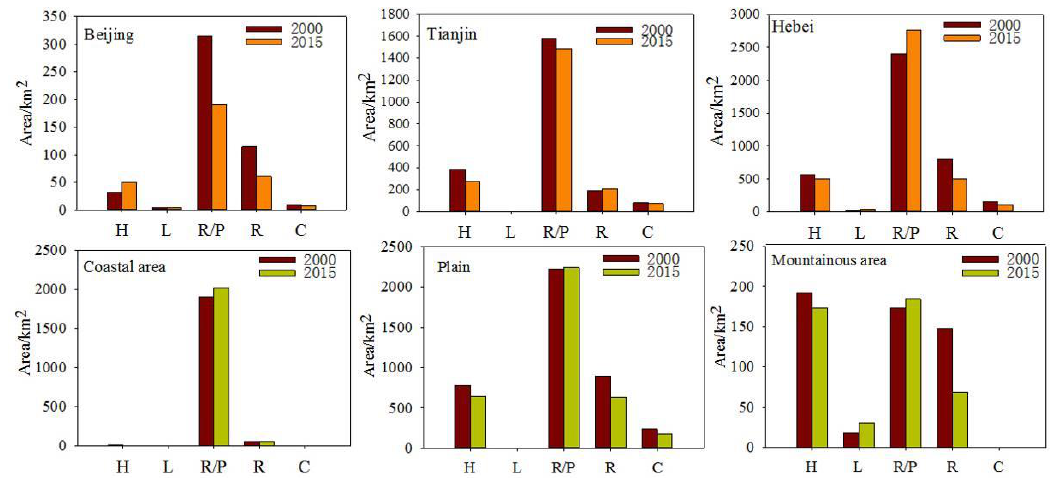
Figure 3. Comparison of total wetland area for each wetland subclass in 2010 and 2015 for Beijing, Hebei, Tianjin, coastal areas, plains, and mountainous areas. Note: H = herbaceous swamps; L = lakes; R/P = reservoirs/ponds; R = rivers, C = canals/channels.